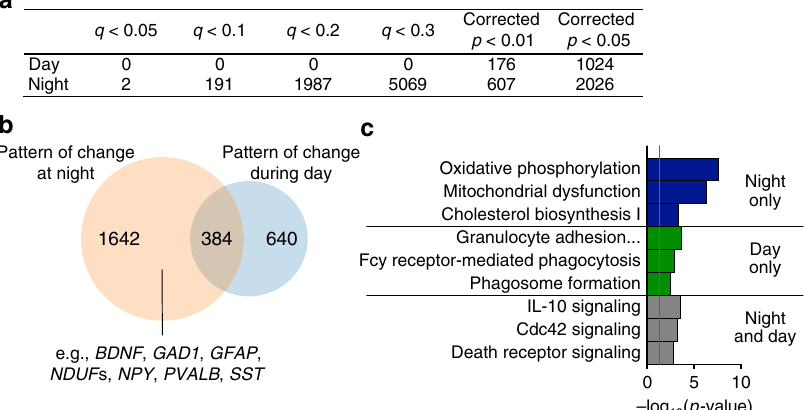
subjects that died at night are primarily related to mitochondrial and GABAergic signaling ( GAD1, GAD2, NPY, PVALB, SST, CCK, for example) which are mostly downregulated (Fig. 5c).